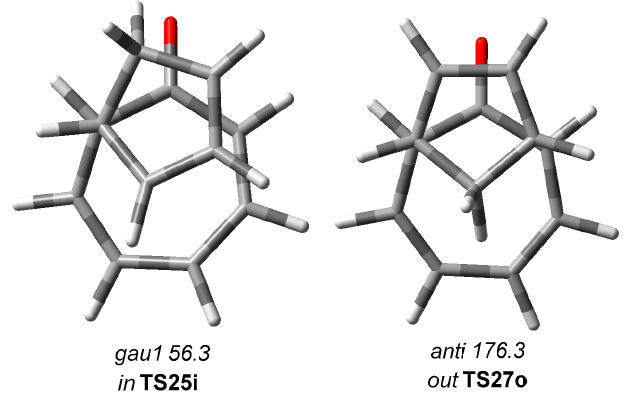
Figure 6. View of TS25i and TS27o along the C2–C9 single bond formation. The C10–C9–C2–C1 dihedral angles are provided in sexagesimal degrees.